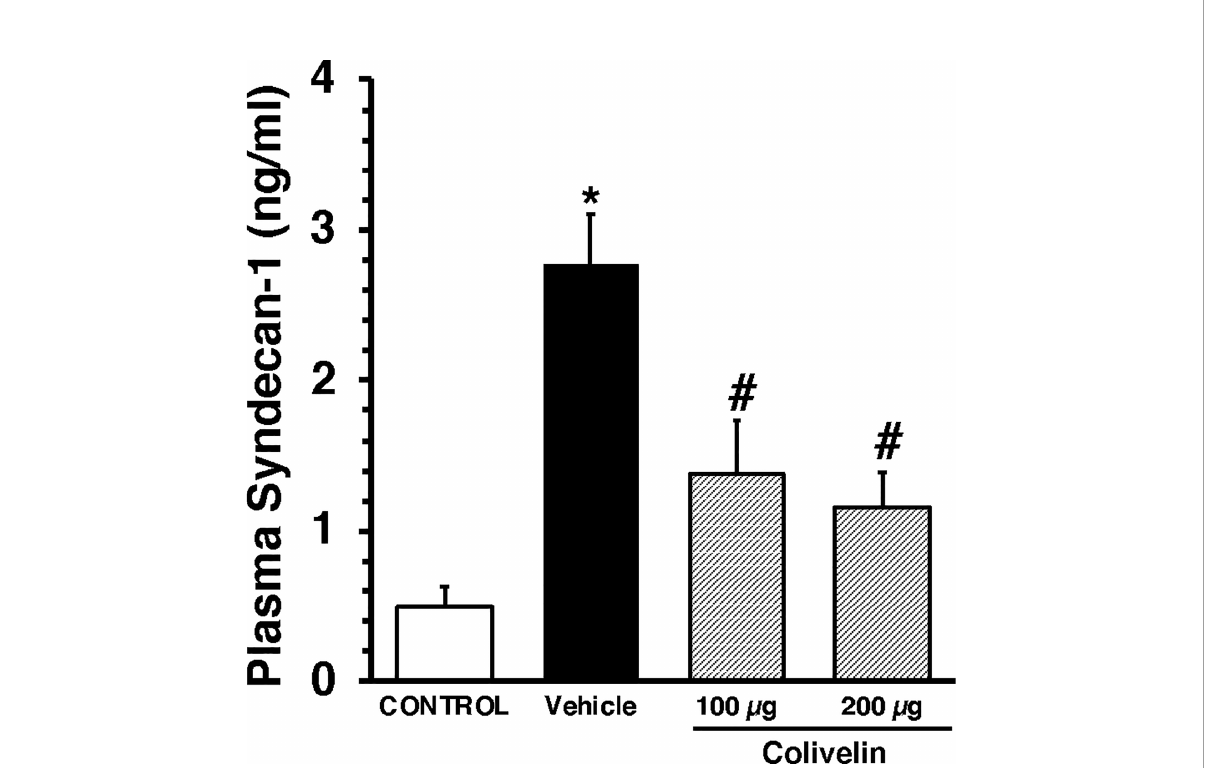
FIGURE 5 Plasma levels of Syndecan-1 at 6 h after cecal ligation and puncture (CLP). Vehicle (200 µl distilled water) or colivelin (100 or 200 µg/kg) was administered intraperitoneally at 1 h after CLP. Data represents the mean ± SEM of 7-13 mice for group (n=10 control group, n=13 vehicle group, n=7 colivelin 100 µg group, n=11 colivelin 200 µg group). *Represents P < 0.05 versus control mice; #represents P < 0.05 versus vehicle-treated